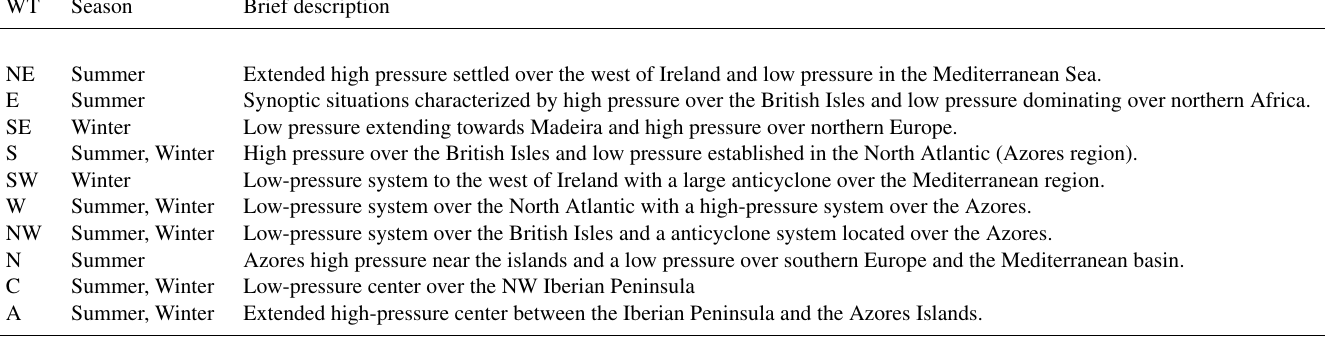
Table 2. A brief description of the pure predominant WTs used in the analysis. The bulk of this information was obtained by Ramos (2012).